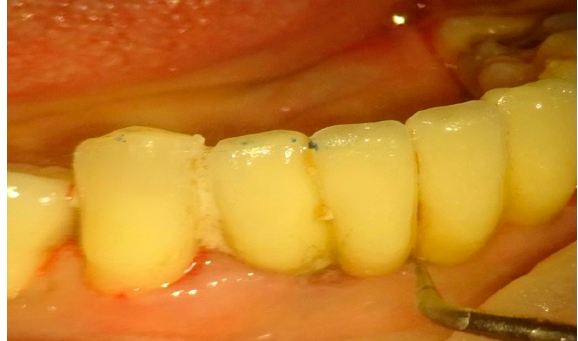
Figure 1. High-frequency ultrasound with betadine diluted to 1/10 .